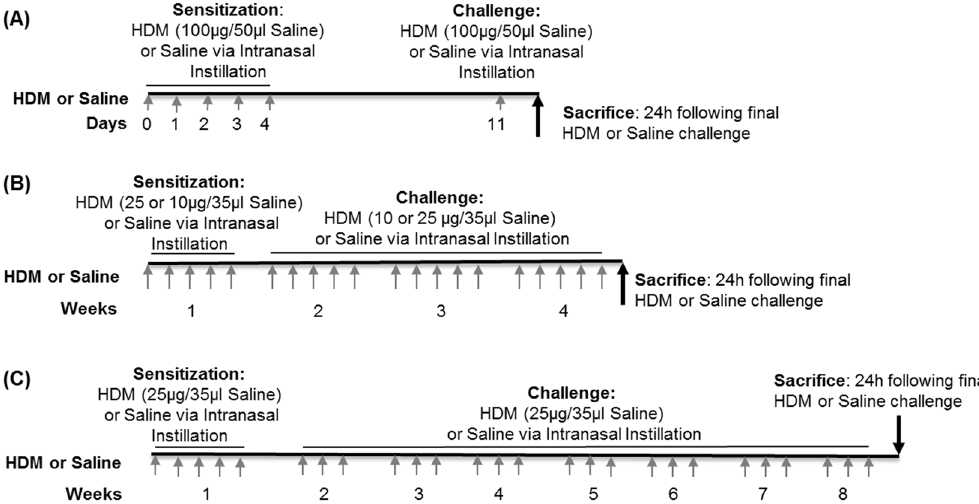
Figure 1. Timelines for allergen exposure in the 3 different HDM models. ( A ) Acute 2-week model of HDM- induced airways inflammation. Mice were sensitized by intranasal instillation of 100 µ g HDM in 50 µ l saline or 50 µ l saline alone (Control) on days 0–4 and then challenged with 100 µ g HDM on day 11. ( B ) Chronic 4-week model of HDM-induced airways inflammation. Mice were sensitized to 10 µ g or 25 µ g HDM in 35 µ l saline or 35 µ l saline alone by intranasal instillation for 5 days/week for 4 weeks. ( C ) Chronic 8-week chronic model of HDM-induced airways inflammation. Mice were sensitized by intranasal instillation of 25 µ g HDM in 35 µ l saline or 35 µ l saline for 5 days a week in week 1, and every Monday, Wednesday and Friday in weeks